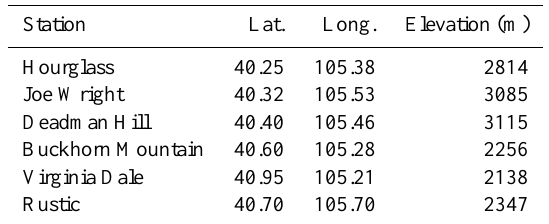
Table 1. Meteorological stations used in test simulations for the Cache la Poudre River basin.